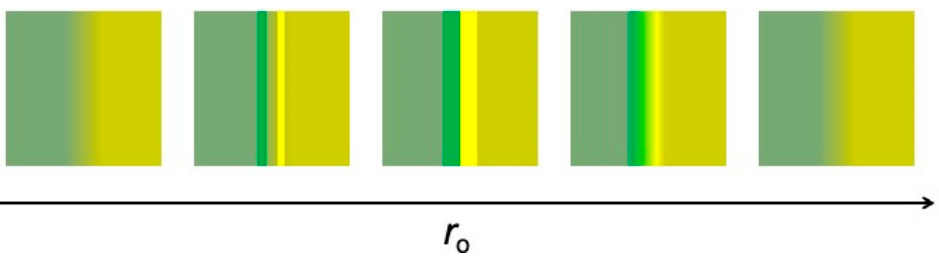
Figure 9. The visibility of a refraction fringe pair changes in a non-monotonic way with the object- detector distance, r o .